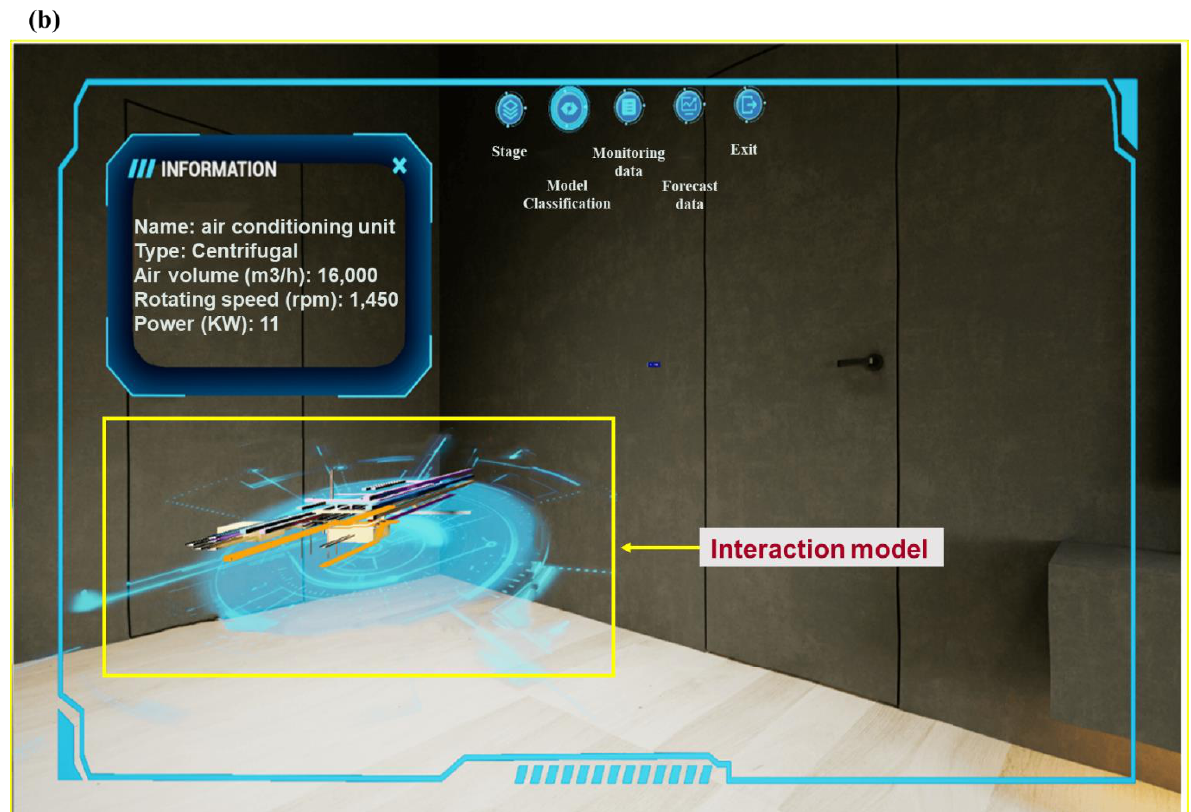
Figure 10. Building structure model and data: ( a ) electromechanical pipeline model and ( b ) air conditioning unit information.